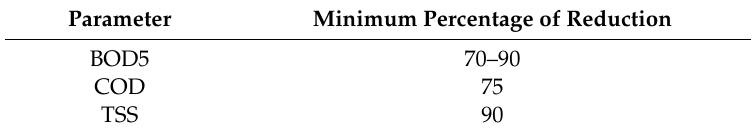
Table 1. Legal limits of discharges to water courses (Directive 91 / 271 / EEC) for organic matter and solids.